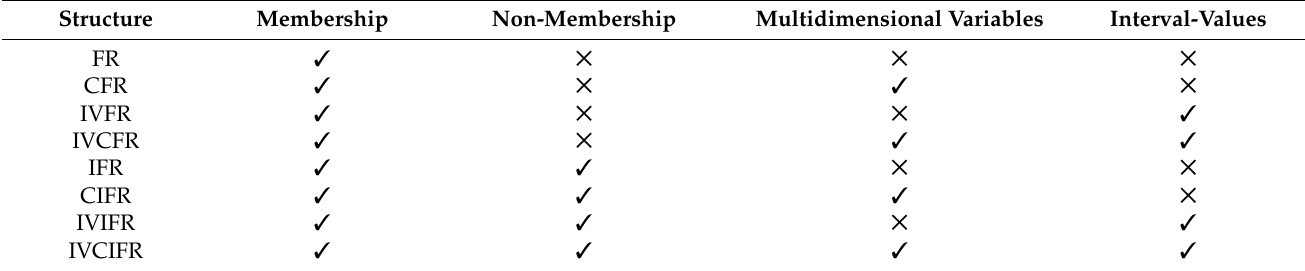
Table 5. Comparison on the basis of structural